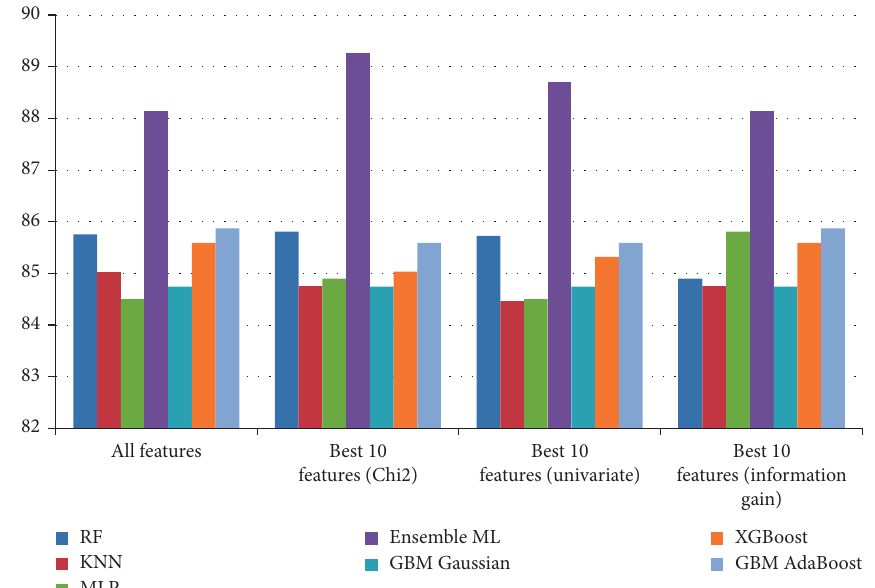
Figure 2: Classifiers accuracy on top 10 features set obtained using three feature selection techniques (Chi-square, Univariate, and In- formation Gain) for Yelp